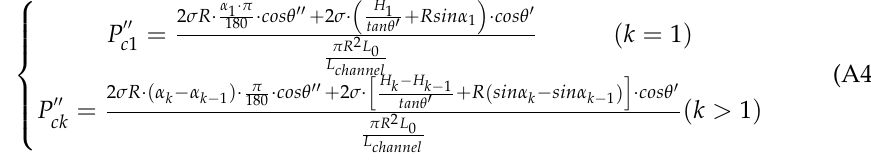
Therein, k represents the ratio of imbibition distance to L 0 ; α k and r k , respectively, represent the height and angle when the corresponding imbibition distance is k · L 0 , as shown in Figure A1. θ (cid:48) represents the contact angle between kerosene and the glass base; θ (cid:48)(cid:48) represents the contact angle between kerosene and the outer wall of the single channel. The height H k in Equation (A4) can be expressed by imbibition distance L , as shown in Equation (A3). Thus, P (cid:48)(cid:48) c in Equation (A4) is a function of L . The relationship between P (cid:48)(cid:48) c and the imbibition distance ( L ) is shown in Figure